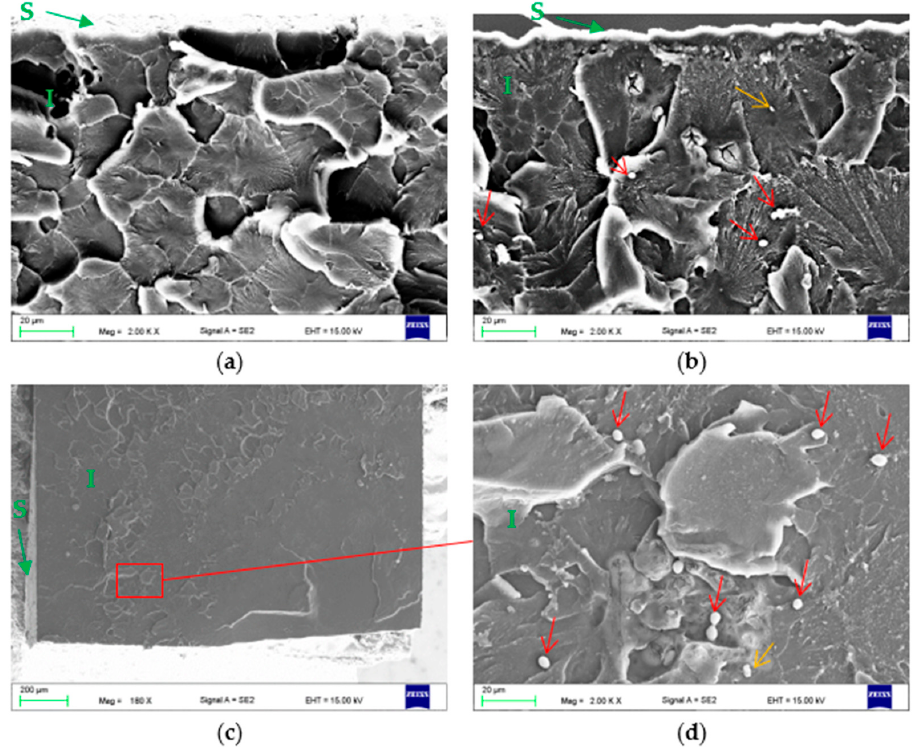
Figure 7. Representative SEM microphotographs of the fractured surfaces (interior of specimens) of the samples after 60 days ( a , b ) and 90 days ( c , d ) incubation in C. albicans suspension. S—surface, I—interior of specimen, red arrows— C. albicans blastospores, yellow arrows—contaminations.